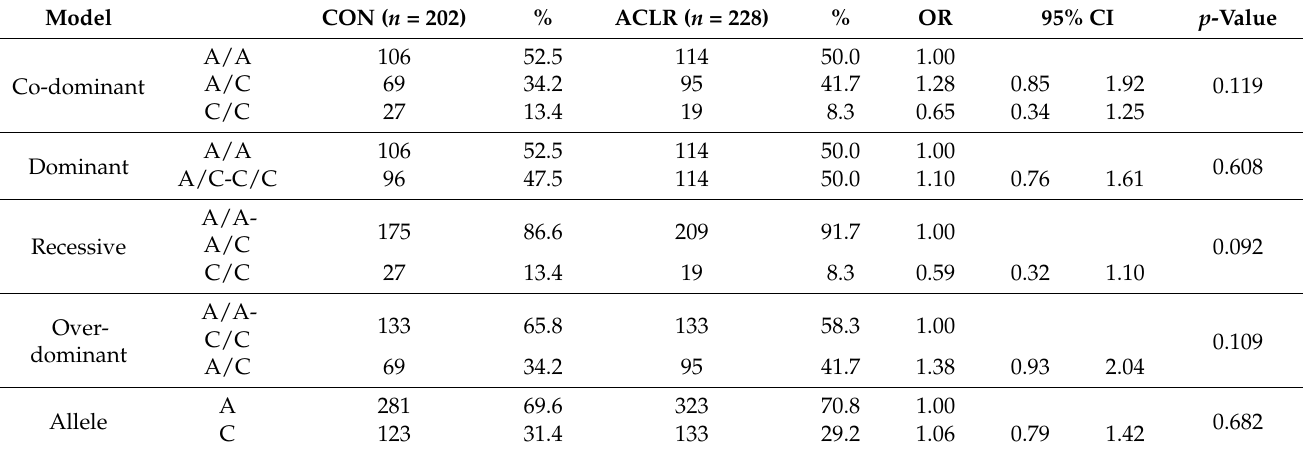
Table 2. Analysis of the relationship between non-contact ACL rupture and the COL22A1 gene rs11784270 A/C